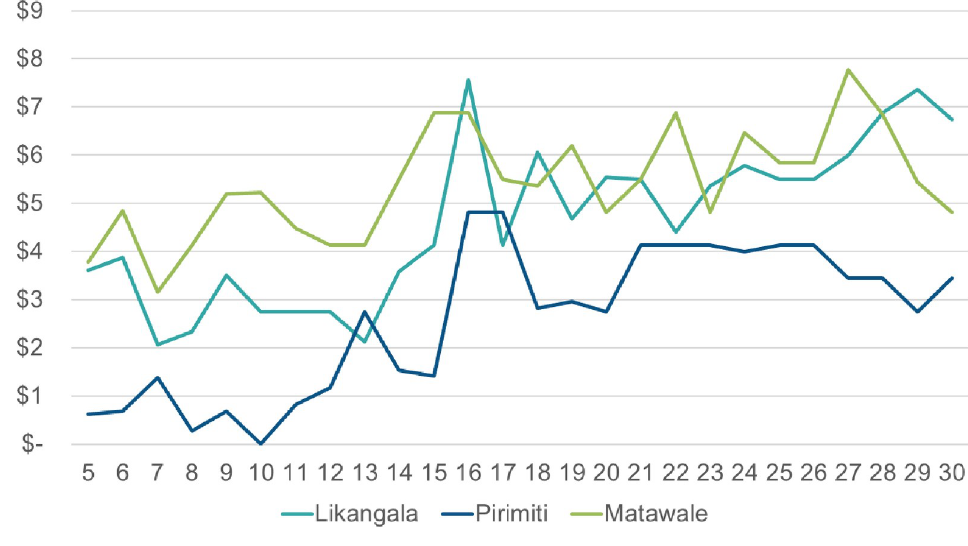
Fig 2. Median weekly cash income by site.